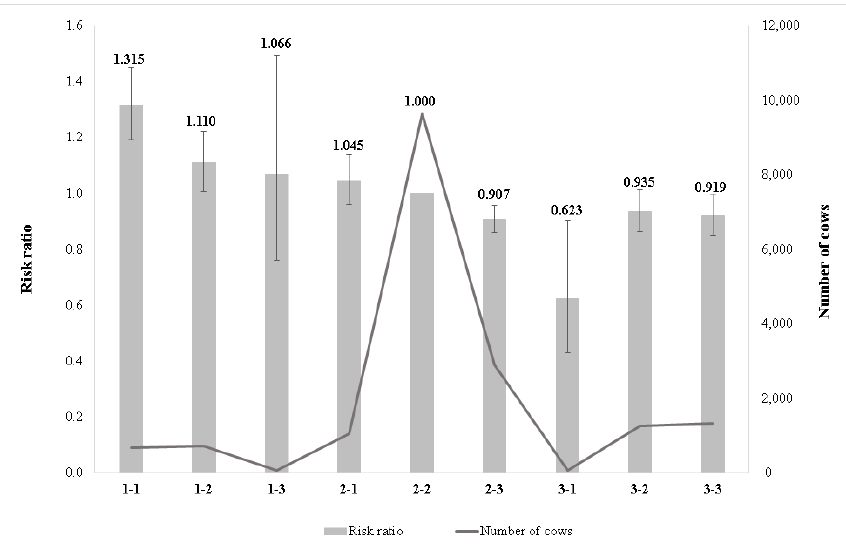
Figure 5. Effect of combination of fore udder attachment and udder depth on the relative culling risk. 1-1 : weak and loose fore udder–deep udder; 1-2 : weak and loose fore udder–intermediate udder depth; 1-3 : weak and loose fore udder–shallow udder depth; 2-1 : intermediate fore udder–deep udder; 2-2 : intermediate fore udder–intermediate udder depth; 2-3 : intermediate fore udder–shallow udder depth; 3-1 : strong and tight fore udder–deep udder; 3-2 : strong and tight fore udder–intermediate udder depth; 3-3 : strong and tight fore udder–shallow udder depth